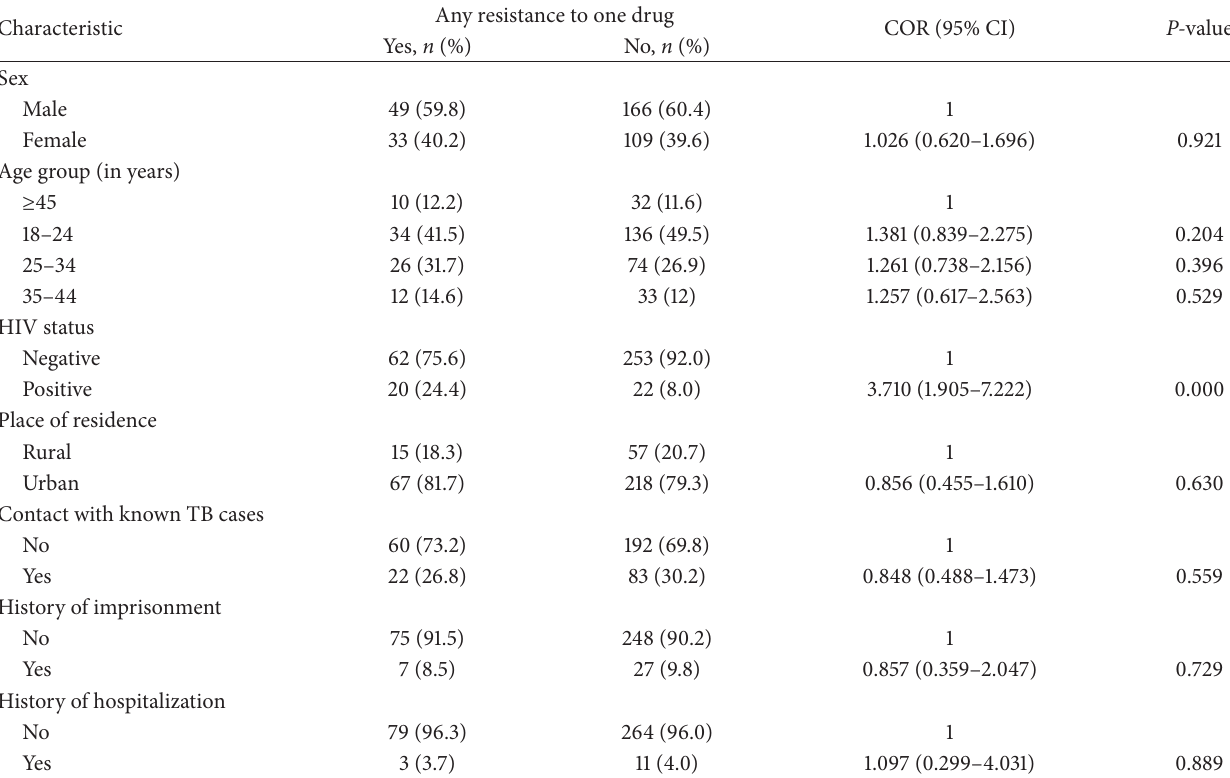
Table 3: Bivariate analysis for selected risk factors for any resistance to one drug among new smear positive pulmonary TB patients in eastern Ethiopia, 2013 ( 𝑛 = 357